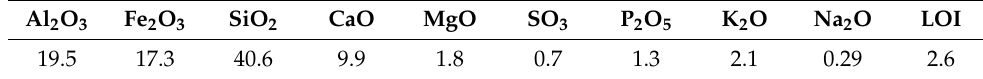
Table 1. Chemical composition of the used fly ash (% by